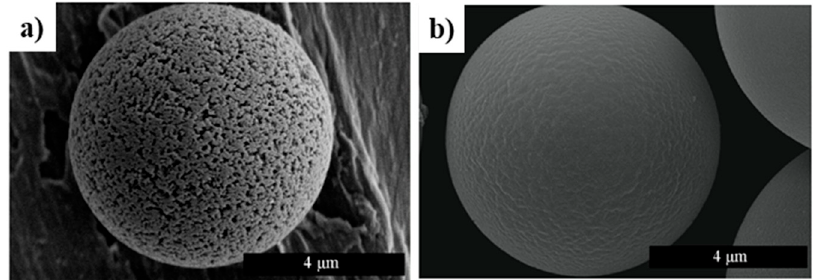
Figure 11. The scanning electron micrographs of ( a ) bare PS-GMA and ( b ) COF@ PS-GMA. Reprinted with permission from [71]. Copyright (2018) Elsevier B.V.